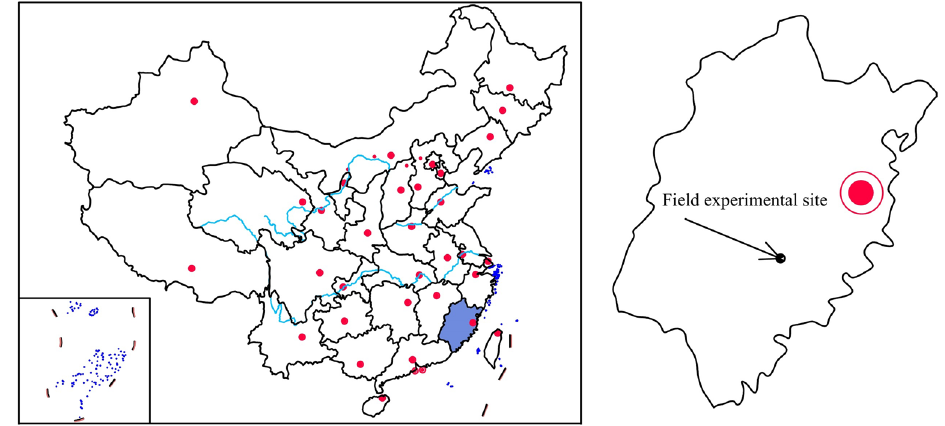
Figure 1. Location of the field experiment site.